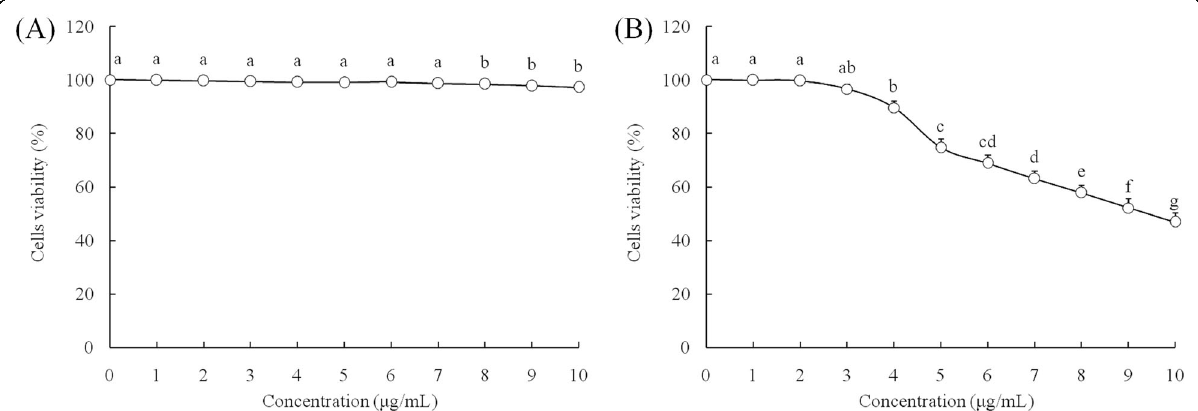
Fig. 2 Effect of resveratrol ( a ) and paclitaxel ( b ) on the growth of HepG2 human liver cancer cells. a-g Mean values with different letters over the points are significantly different ( P < 0.05) according to Dunnett ’ s post-hoc